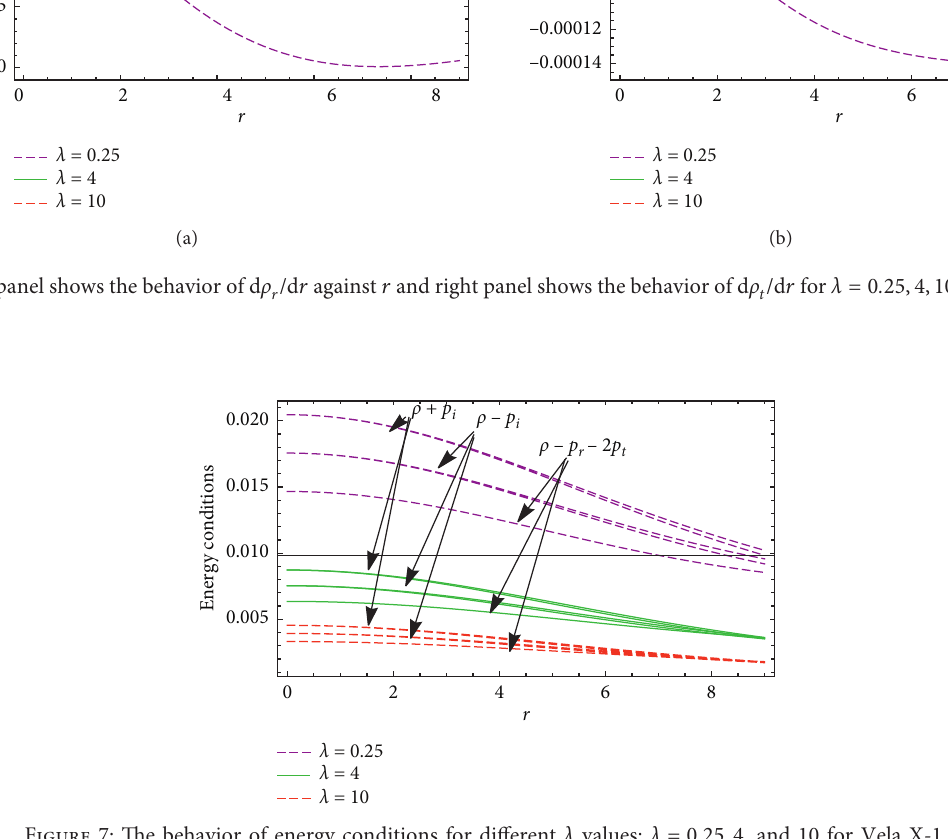
r for λ � 0 . 25 , 4 , 10 for Vela X-1 star t /d